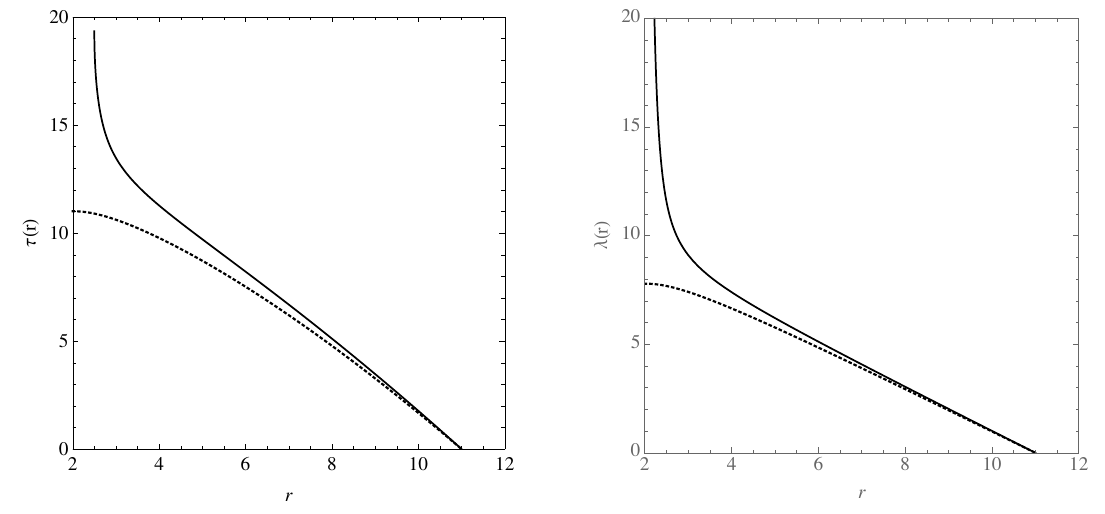
Figure 2 . As in (cid:12)gure 1 for the (cid:13) -metric. The left panel shows the case for a massive particle, the right panel that for a massless one. In these plots, we assume E = M = L = n = 1, (cid:13) = 2, and r in =